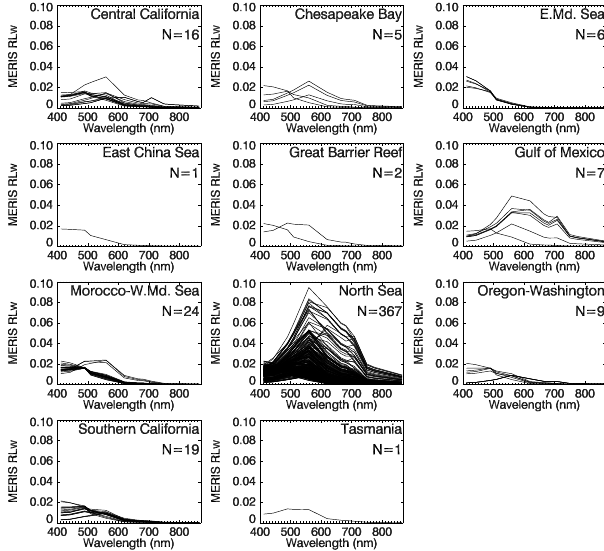
Figure 19. MERIS RLw provided in the CCRR match-up data set for the 11 CoastColour sites.